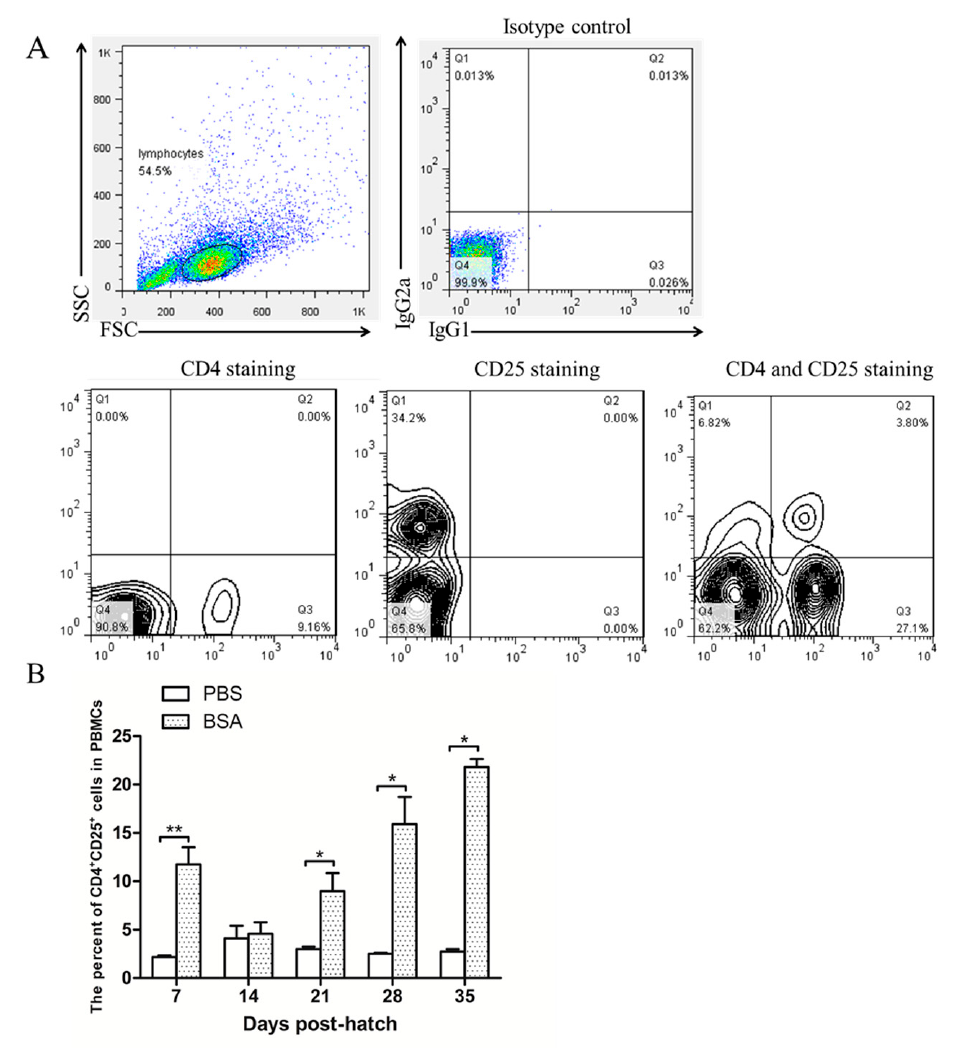
Figure 3. The percentage of CD4 + CD25 + cells by flow cytometry: ( A ) The lymphocytes were grouped and CD4 + CD25 + cells were gated as shown in Figure 3A (up left: lymphocytes group; up right: isotype control; down left: CD25 staining; down middle CD25 staining; down right: CD4 and CD25 staining). ( B ) The percentage of CD4 + CD25 + cells. The error bars indicate the SEM. * p ≤ 0.05; ** p ≤ 0.01. 3.4. Injection of Anti-Chicken CD25 Antibody on EID16 Via Blood Vessel Significantly Blocked CD4 + CD25 + Cells until 35 d Post-Hatch